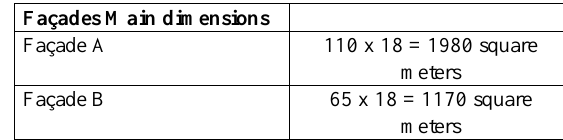
Table 1. Façades’s main